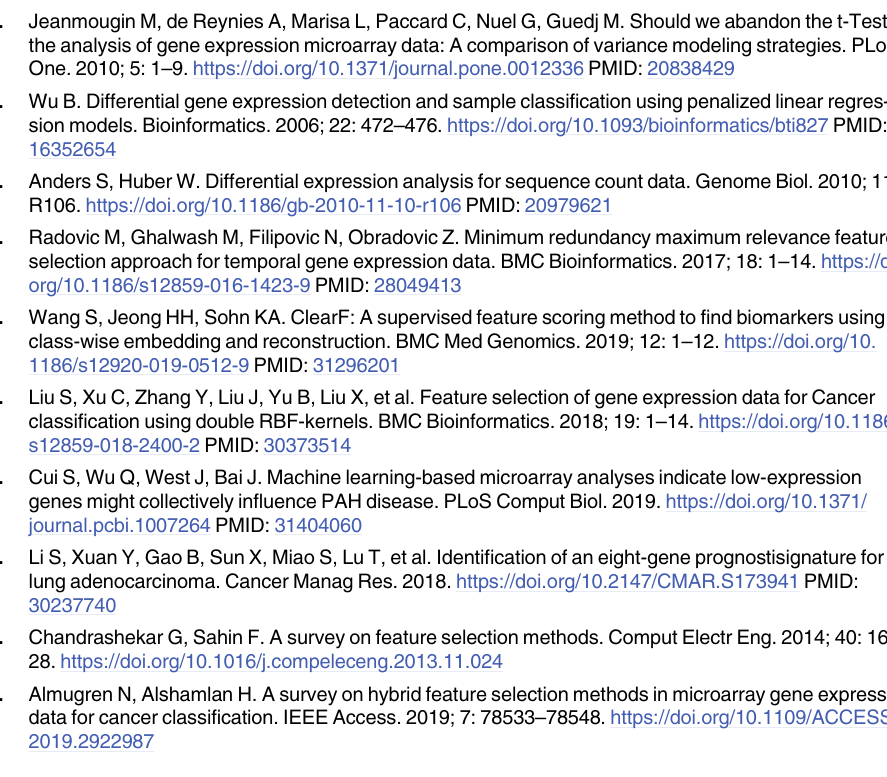
S4 Table. The List of identified differential expressed genes (DEGs) between normal (N) and tumor (T)